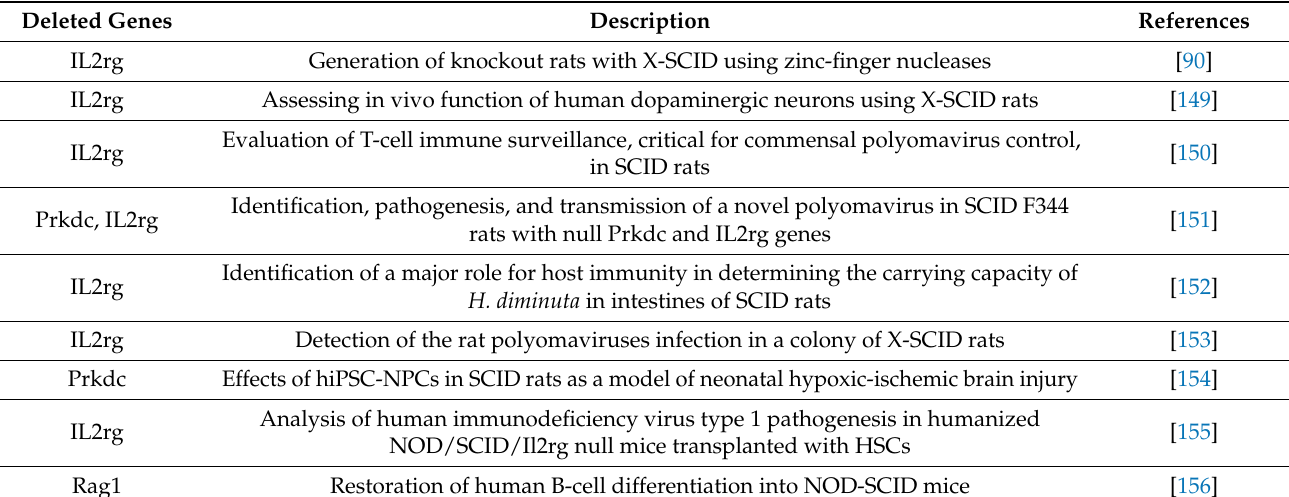
Table 1. Studies using severe combined immunodeficient (SCID) mice and rats and mice as the animal model. Deleted Genes